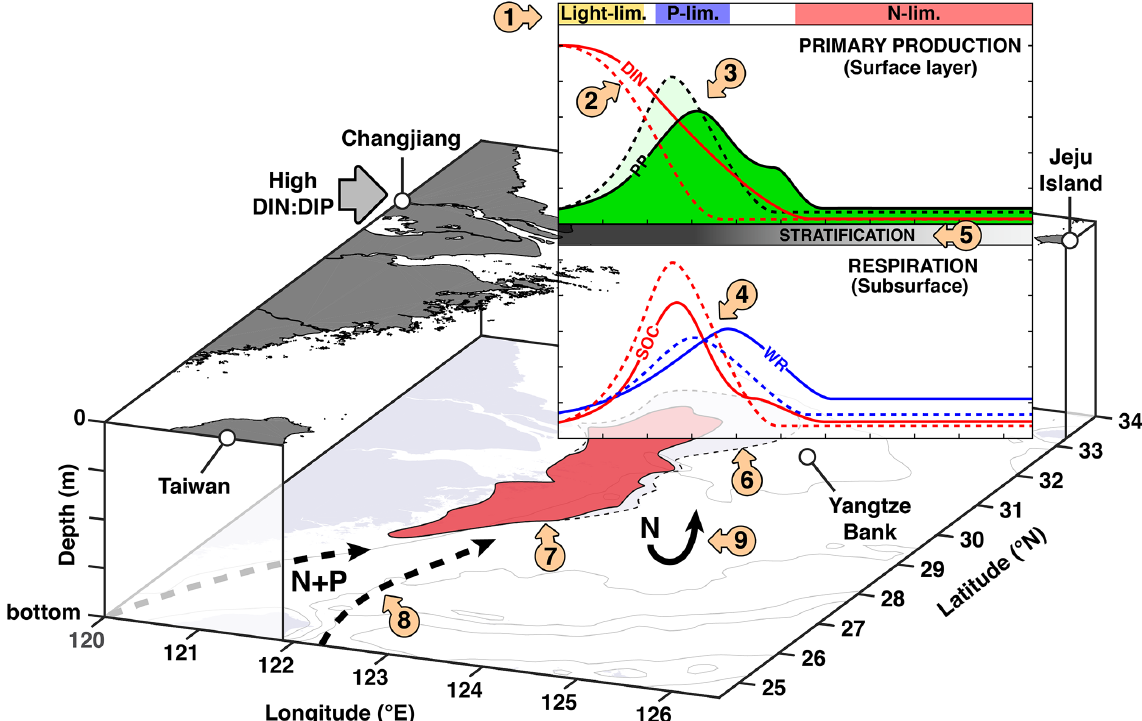
Figure 11. Conceptual model of P limitation on the ECS shelf. Dashed lines indicate the effects without P limitation (NoPlim simulation). (1)–(5) Conceptual model of river-induced P limitation along the Changjiang–Jeju Island transect adapted from Laurent and Fennel (2017). (1) dominant limitation factor; (2) spatial and temporal relocation of “excess N”; (3) spatial relocation and dilution of PP; (4) spatial shift and dilution and vertical relocation of respiration; (5) weakening of stratification due to plume mixing; (6) mitigating effect on the northern hypoxia core and the Yangtze Bank; (7) no effect of P limitation on the southern hypoxia core; (8) nutrient sources from the Taiwan Strait and the Kuroshio as shown by Große et al. (2020); (9) lower denitrification represents a small positive feedback on